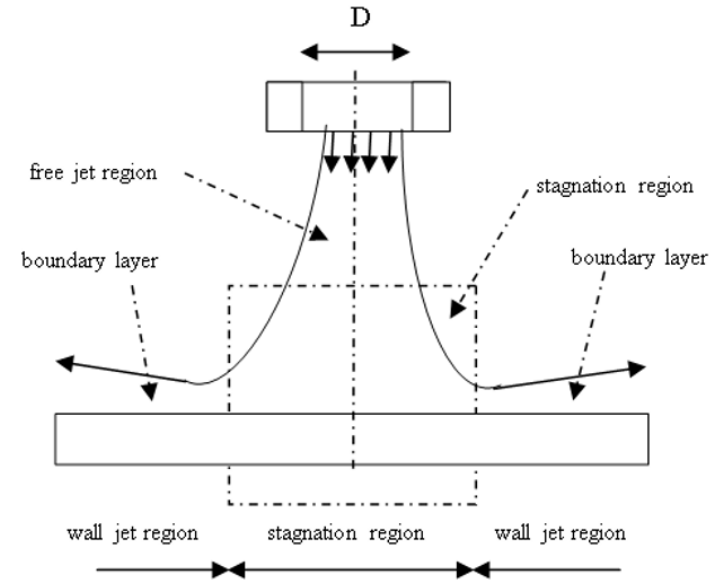
Figure 5. Characteristics of flow through a single nozzle.